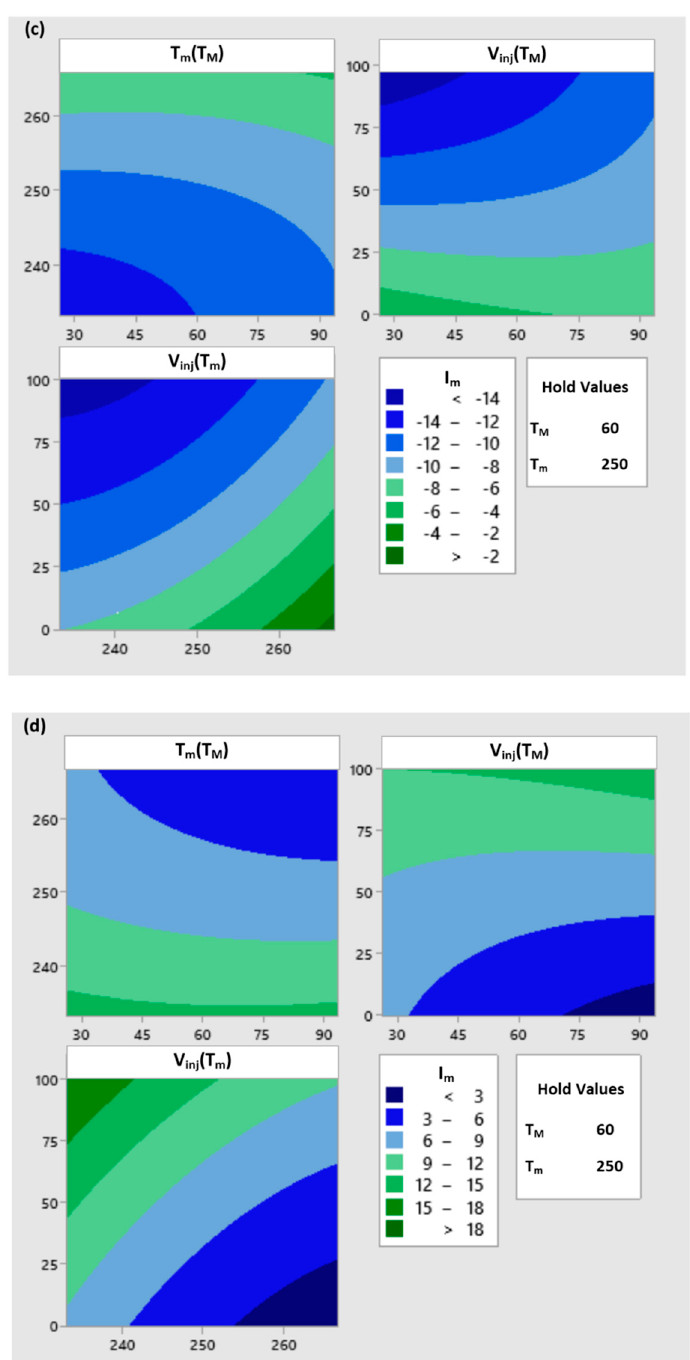
Figure 5. Effect of process parameters on the filling imbalance for various runner layouts: ( a ) standard GS, ( b ) one correction element G1, ( c ) two correction elements G2, ( d ) circled element G3.